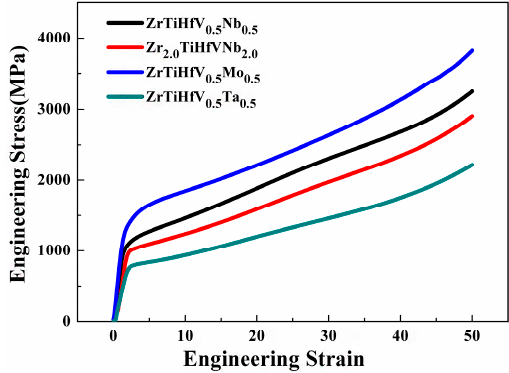
Figure 5. The static compression engineering curves of the RHEAs.